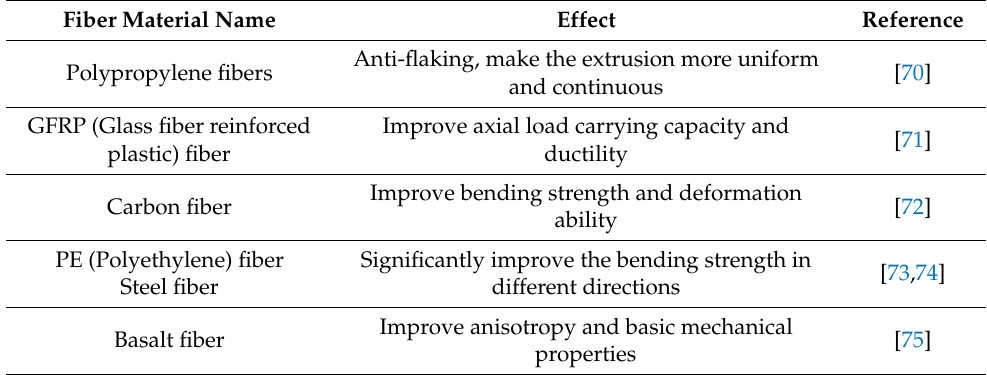
Table 3. The effect of different fiber materials on